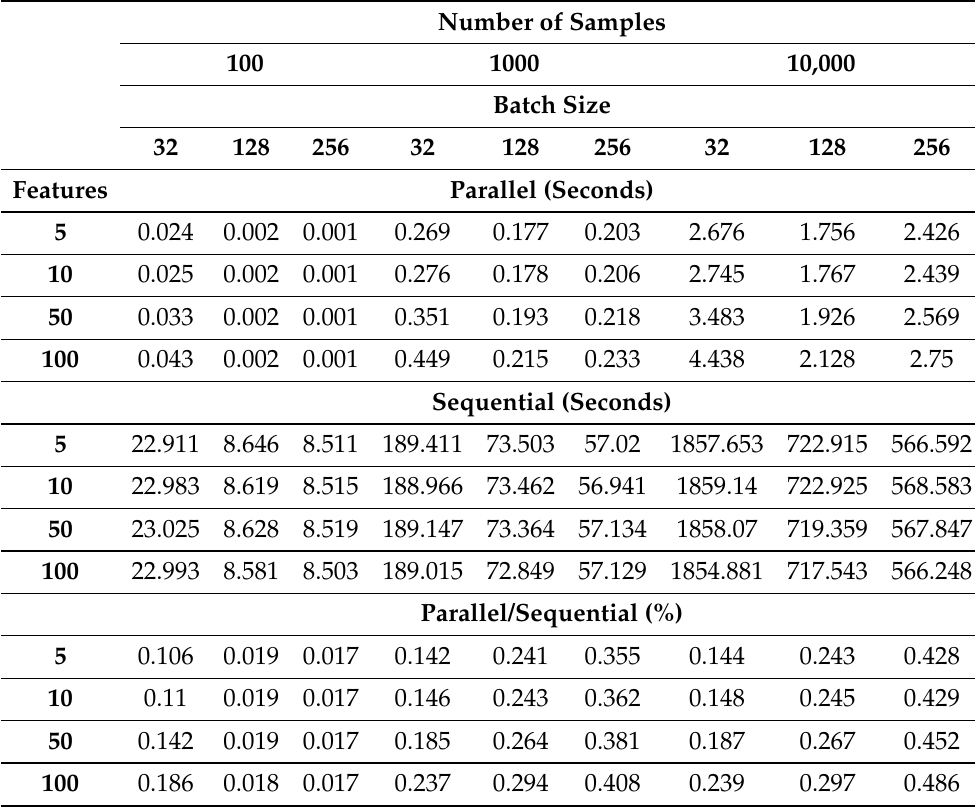
Table 2. Average of 10 epochs to train 10,000 models using a